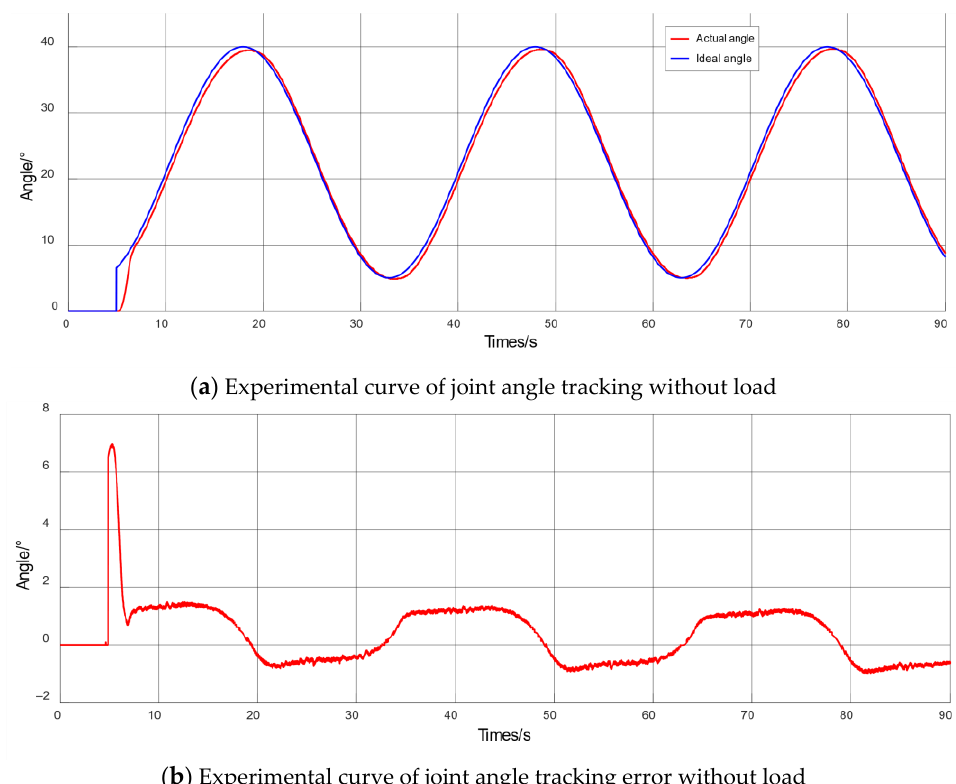
Figure 9. Passive training process under no load.